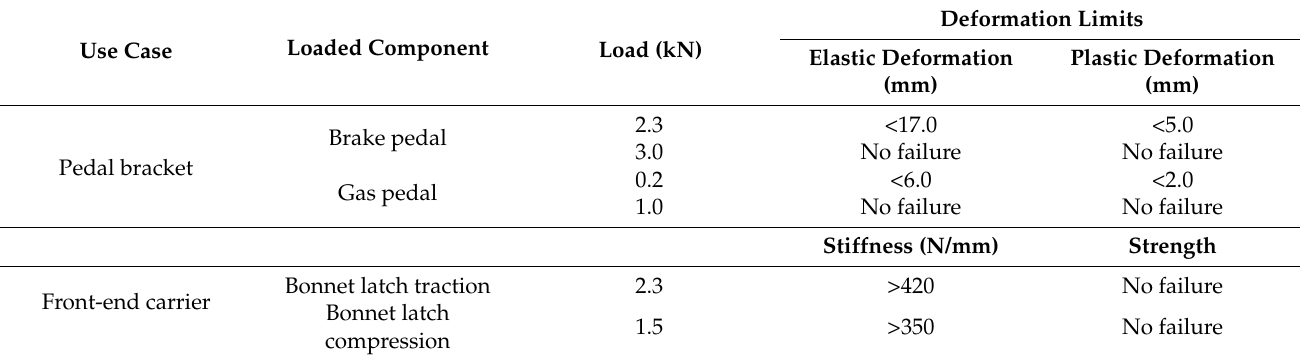
Table 1. Validation test cases for the macroscale use case